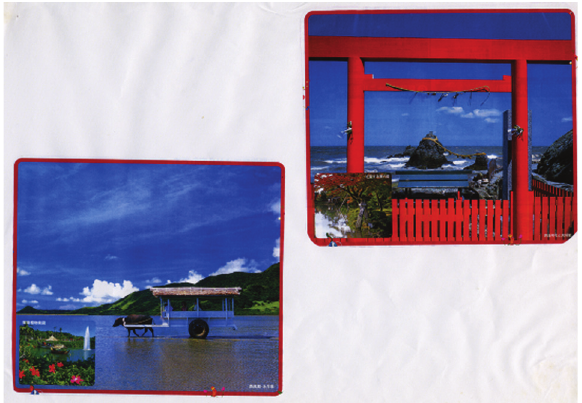
Figure 1. An example of simplification.